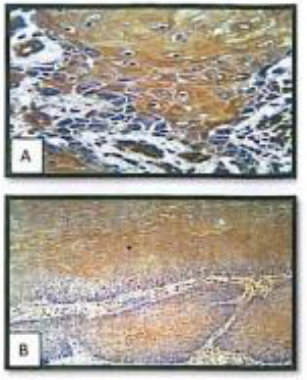
Figure 2: VEGF immunoexpression in A. SCC B. VSCC Table 4: D2-40 tumor cell scores in OSCC